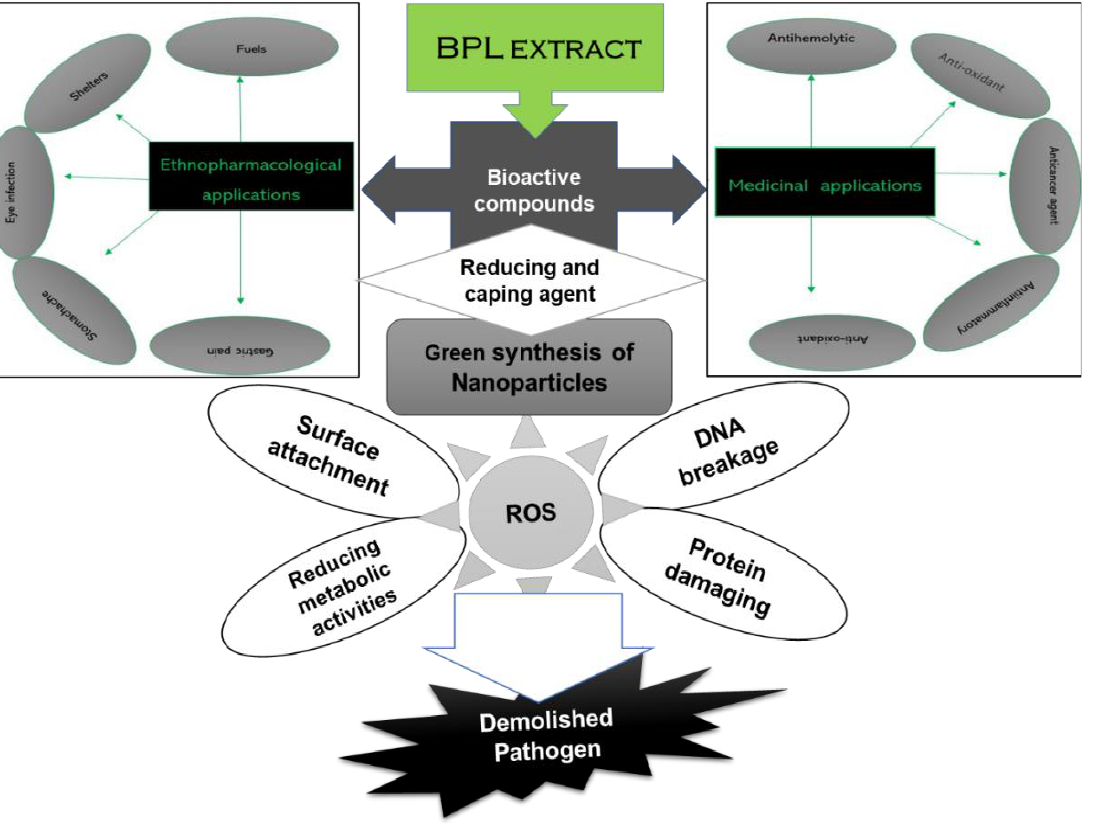
Figure 9. Applications of Berberis plant in biomedical and green synthesis of NPs and the hypothetical action mechanism of nanoparticles against microbial pathogens.